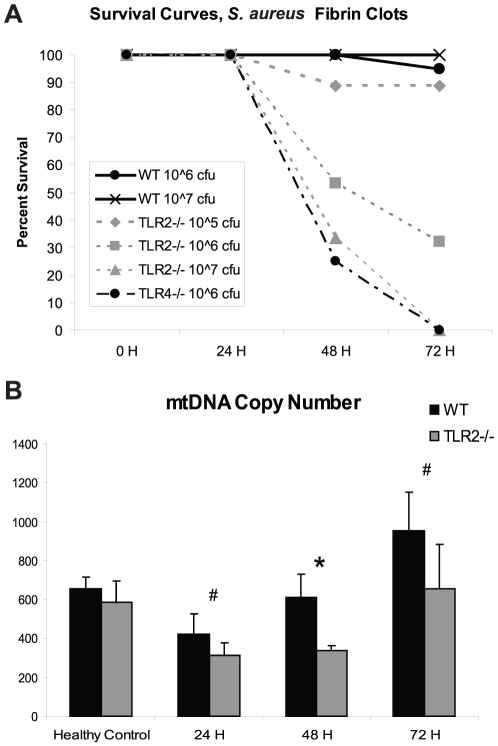
Survival curves and mtDNA content in S. aureus sepsis.(A) Survival curves for WT, TLR2−/−, and TLR4−/− mice are shown. Doses of 10∧5, 10∧6, and 10∧7 are shown for TLR2−/− mice, showing dose-response effects. (B) Absolute mtDNA content in WT and TLR2−/− was measured by Q-PCR of Cyt b in comparison to known standard. TLR2−/− mtDNA content is lower than WT mtDNA content in S. aureus sepsis at each time point (n = 4 at each time point; #, p = 0.05; *, p<0.01).